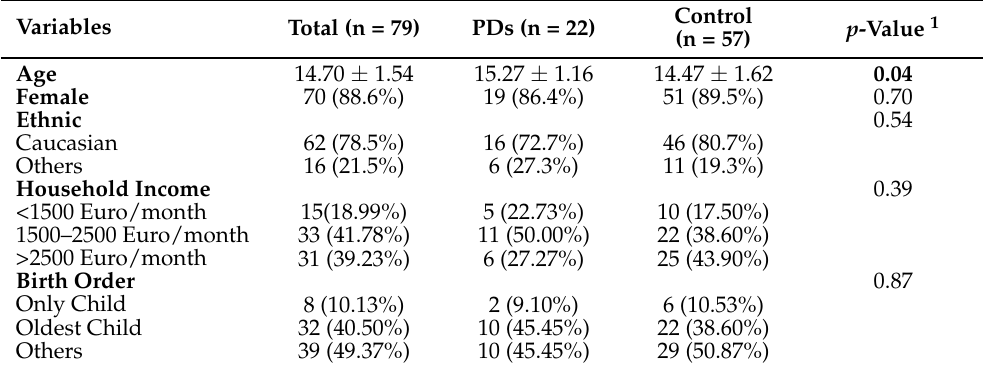
Table 1. Sociodemographic and clinical-psychological features of the